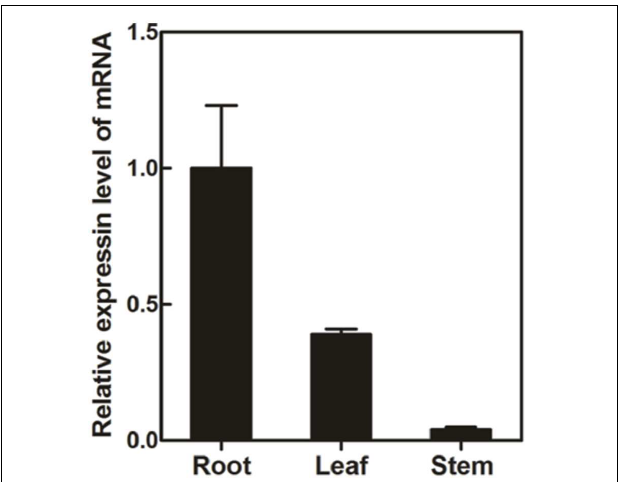
FIGURE 5 | Quantitative real-time reverse transcription PCR (qRT-PCR) analysis of the PlUGT2 trancript abundance in different organs of P. lobata . The transcript abundance of PlUGT2 in different organs were normalized to the actin (internal reference) and expressed relative to the values of roots (control), which was set the value of 1. The data were derived from three biological replicates. The primer sequences used for qRT-PCR analysis are shown in Supplementary Table